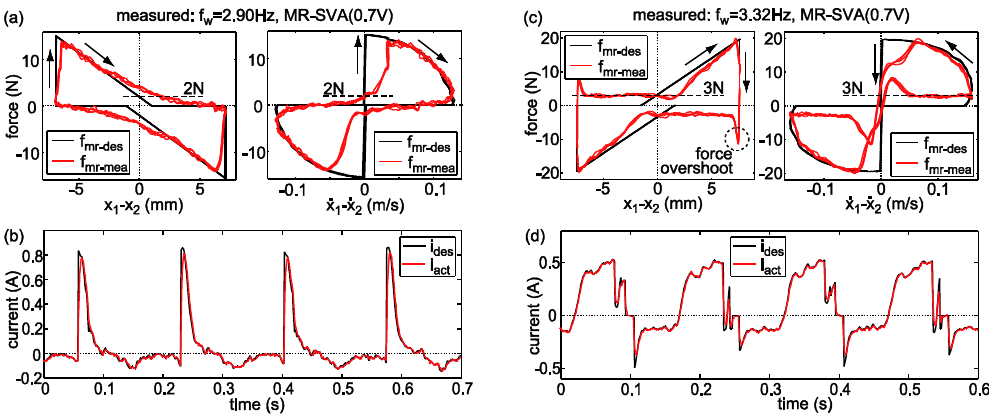
Figure 14. Measured force tracking control for ( a , b ) large negative desired stiffness due to